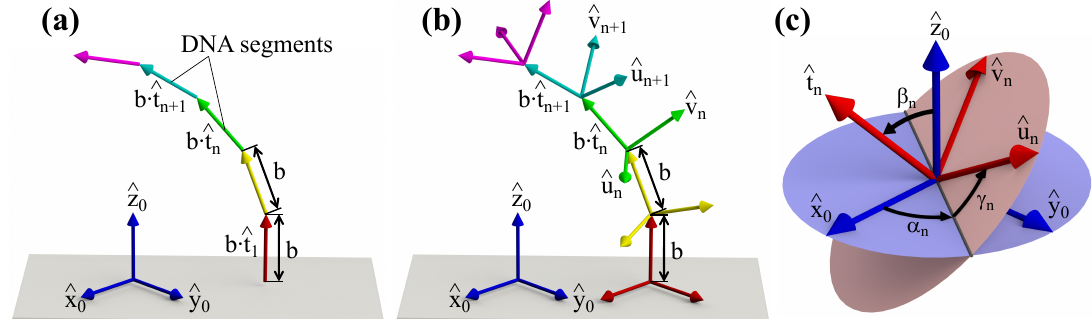
Figure 1. Discretized model of DNA. In theoretical computations, the DNA polymer is usually represented by a polygonal chain comprised of short DNA segments of equal length, b . While in the case of torsion-free DNA, the global DNA conformation is completely specified by the set of unit tangent vectors ( ˆ t 1 ,..., ˆ t N ) of the respective DNA segments ( a ). In a more general scenario, one needs to know the 3D-orientations of all of the DNA segments, which are treated as solid rigid bodies with attached local Cartesian coordinate frames ( ˆ t n , ˆ u n , ˆ v n ) ( b ). ( c ) Schematic picture of the three Euler rotation angles ( α n , β n , γ n ) determining the orientation of the n -th DNA segment with respect to the ) fixed global coordinate system ( ˆ x , ˆ y , ˆ z 0 0 0